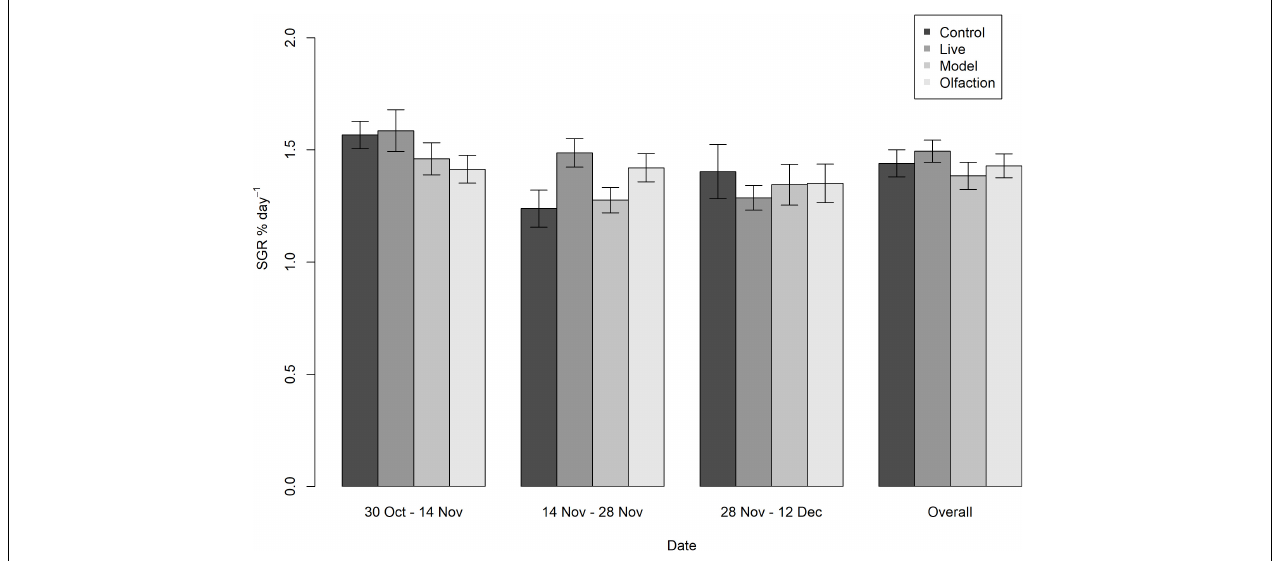
FIGURE 1 | Specific growth rate (SGR % day − 1 ) in lumpfish ( n = 40 per treatment) during 6 weeks of interaction with Live, Model or Olfaction treatments or Control. Mean measurements with 95% confidence interval error bars revealed no difference between treatments measured every second week, including an overall measurement comparing initial weight with endpoint